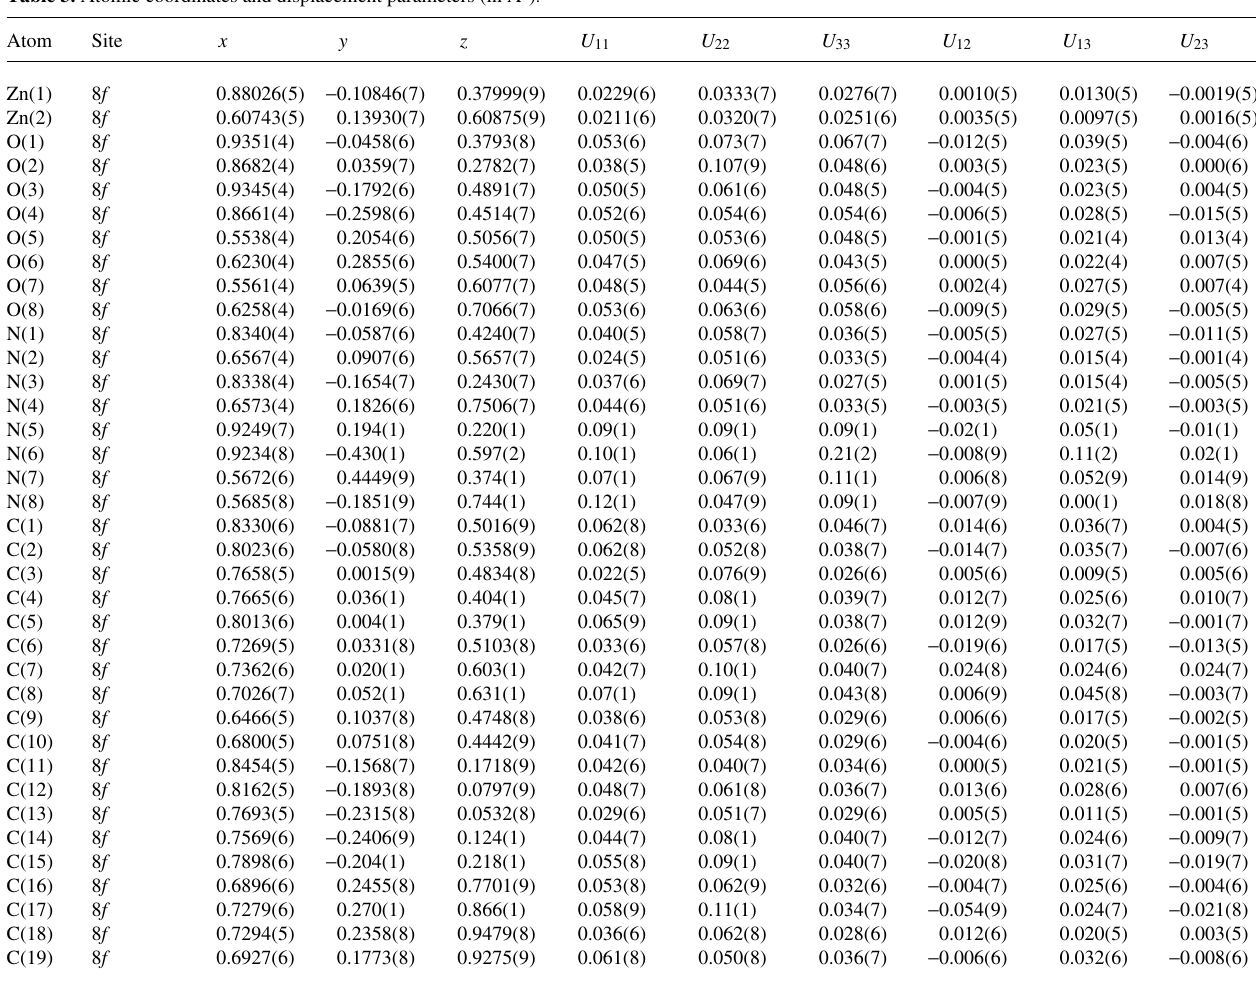
Table 3. Atomic coordinates and displacement parameters (in Å 2 ) .